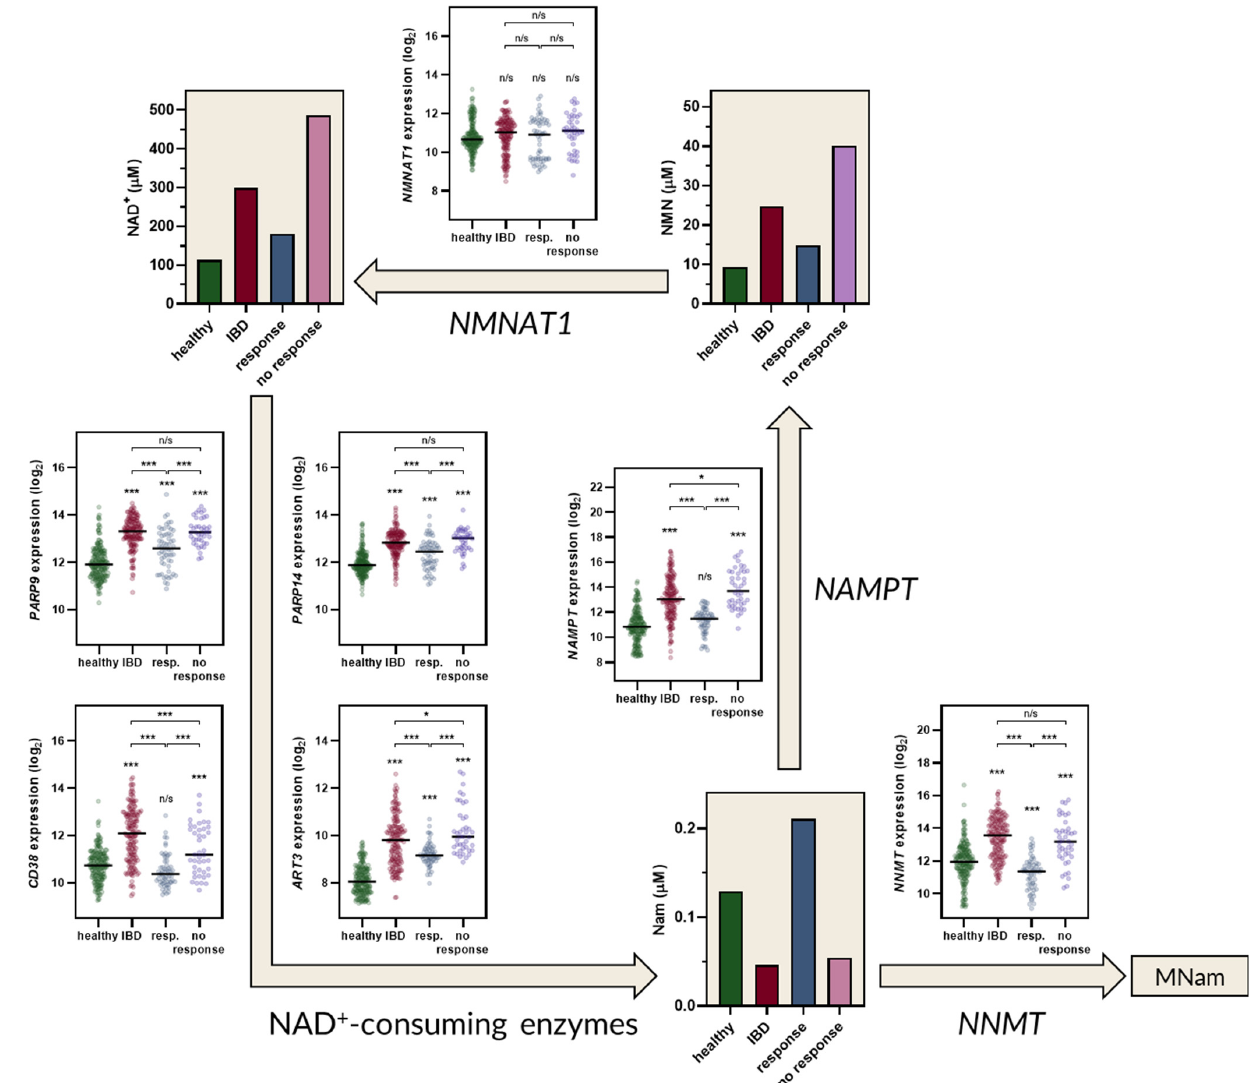
Figure 4. Predicted concentrations of NAD + metabolites in the intestine mucosa of healthy controls, patients with inflam- matory bowel disease (IBD), IBD patients responding to infliximab treatment (resp.), and IBD patients non-responding to infliximab treatment (no response). For simplicity, only the key elements of the NAD + biosynthesis pathway are shown. Expression values of key enzymes used for pathway modeling are shown as scatter plots. Statistical analysis: one-way ANOVA with Tuckey’s post-hoc test. *, p -value < 0.05; ***, p - value < 0.001. Metabolites: Nam, nicotinamide; NAD, nicotinamide adenine dinucleotide; NMN, Nam mononucleotide; MNam, methyl-Nam. Enzyme-coding genes: NMNAT1 , nicotinamide nucle-otide adenylyltransferase 1; NAMPT , nicotinamide phosphoribosyltransferase; NNMT , nico-tinamide N-methyltransferase; PARP9/14 , poly(ADP-ribose) polymerase 9/14; CD38 , cyclic ADP-ribose hydrolase; ART3 , ecto-ADP-ribosyltransferase